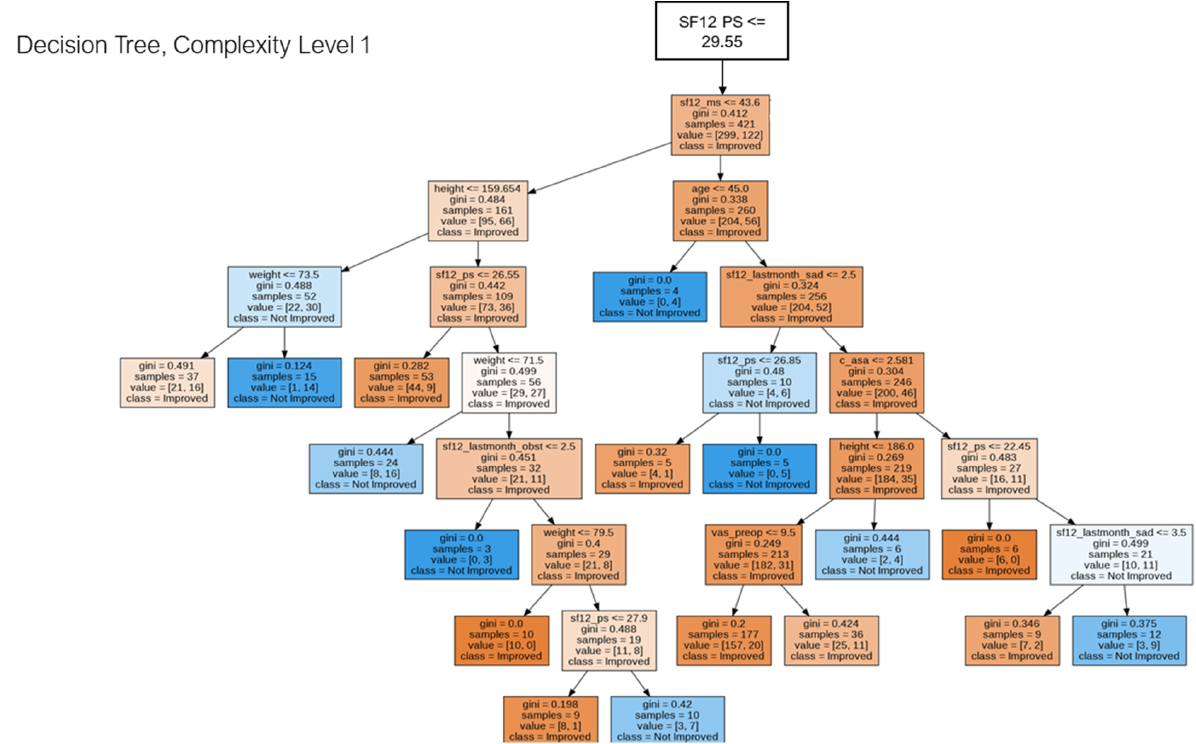
Figure 2. Decision Tree visualization (sub-tree), low complexity.